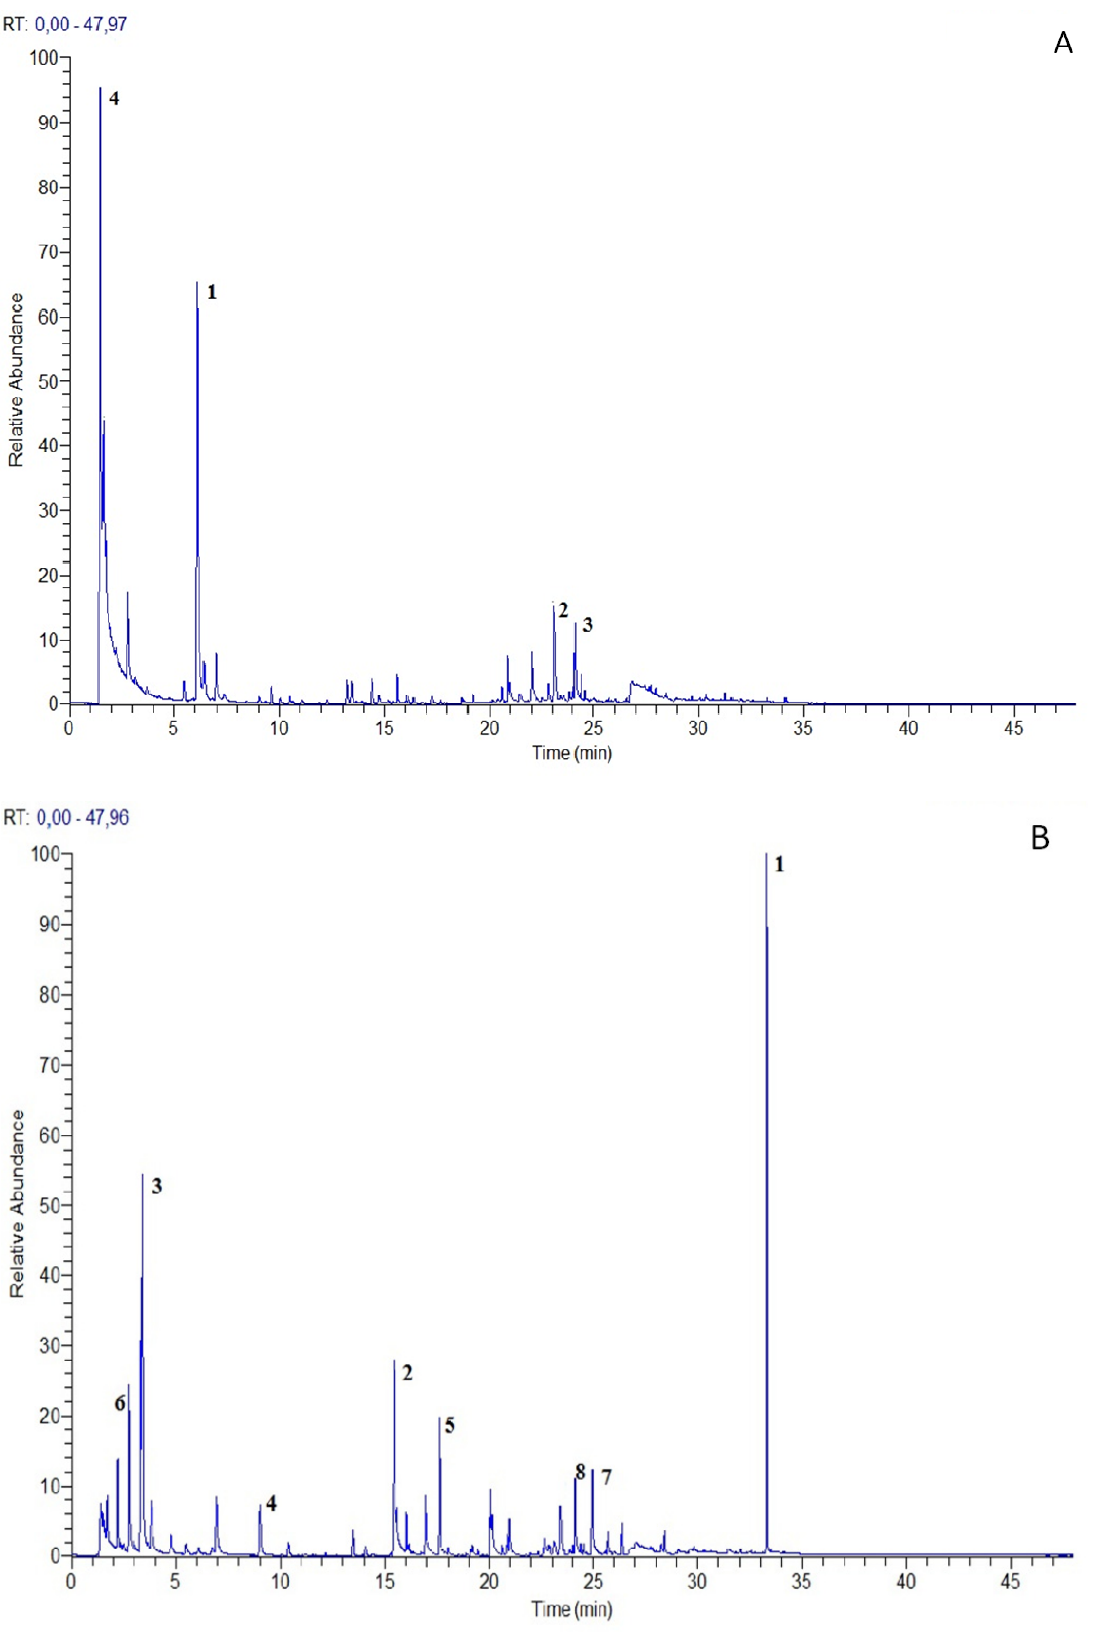
Figure 2. Volatile fingerprint of O. sphegodes subsp. sphegodes ( A ), O. bertolonii subsp. benacensis ( B ) and N. tridentata ( C ) picked flowering plants (the most representative compound peaks were labeled with